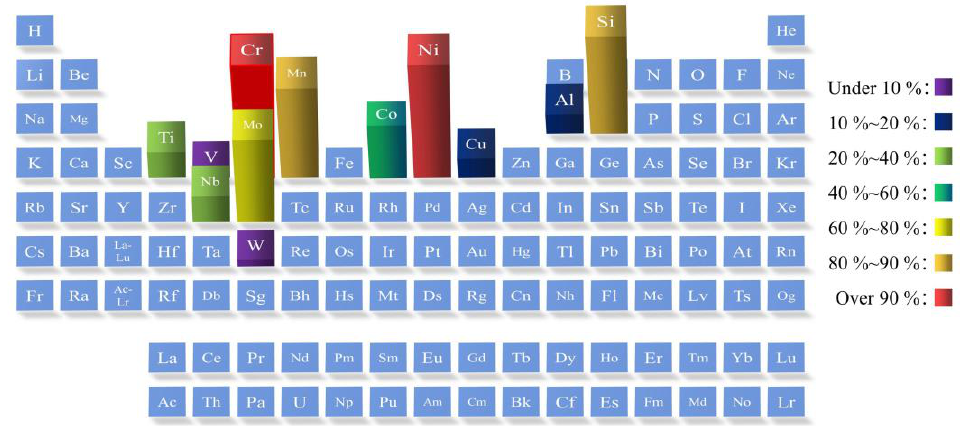
Figure 2. Common alloying elements with their frequency of occurrence in typical high-strength stainless steel [50 – 58]. Table